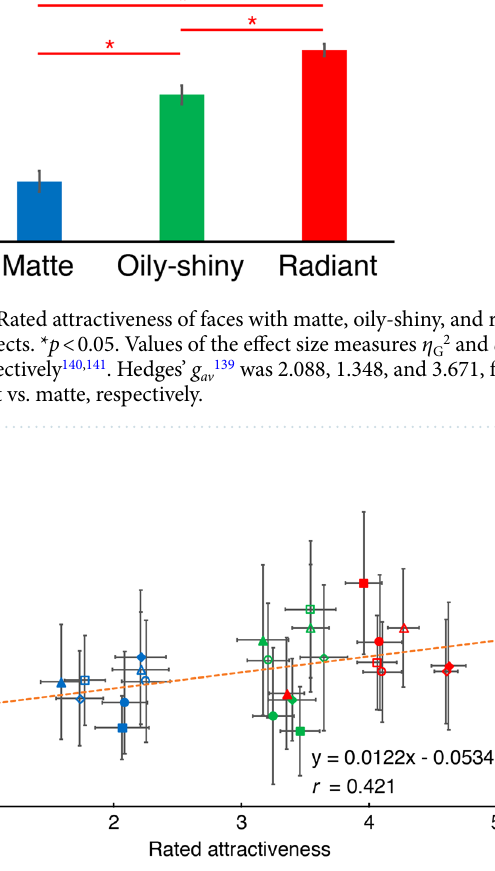
Fig. S3, Table S1, and Fig. S4 online, respectively. To examine whether the level of activity in the mOFC reflects the magnitude of facial attractiveness based on skin reflection, we compared the mOFC activation for all 24 facial images with the attractiveness rating from the psychological experiment. Activity in the mOFC was positively correlated with attractiveness (one-tailed correlation test, r = 0.421, p = 0.020, Fig. 4). This finding was also confirmed using a simple linear regression analysis with a one-tailed slope test ( p = 0.020).